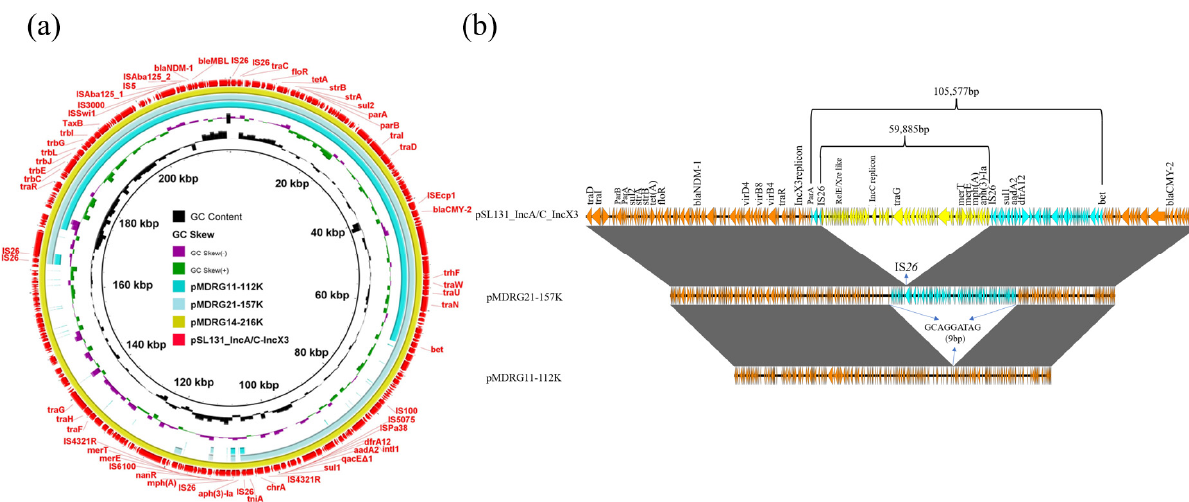
Figure 2. ( a ) Circular comparison of cointegrate plasmid pSL131_IncA/C_IncX3 with three plasmids from transconjugants of EC600 selected by MTR plates. Outermost circle with red arrows represents reference pSL131_IncA/C_IncX3. ( b ) Linear comparison of cointegrate plasmid pSL131_IncA/C_IncX3 with two structurally altered plasmids. Arrows marked in yellow indicate discarded regions from pSL131_IncA/C_IncX3 to pMDRG21-157K, and regions marked in yellow and blue represent dis- carded regions from pSL131_IncA/C_IncX3 to pMDRG11-112K.